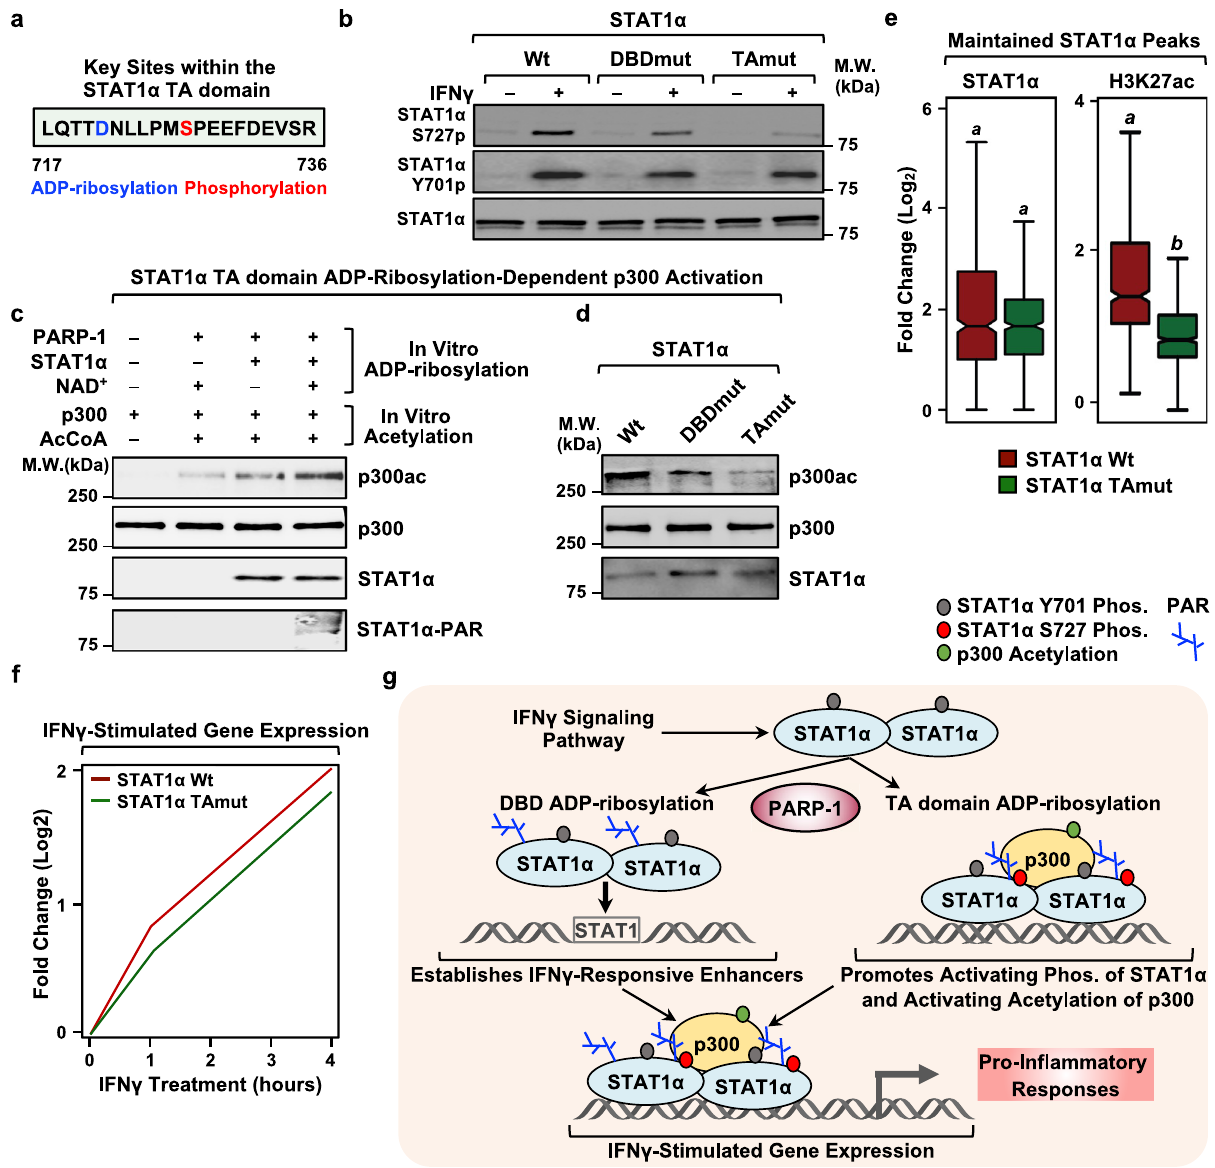
Fig. 6 ADPRylation on its TA domain is required for IFN γ -dependent phosphorylation of STAT1 α and activation of p300. a Amino acid sequence showing the ADPRylation (blue) and phosphorylation (red) sites in the TA domain of STAT1 α . b ADPRylation at D721 in the TA domain of STAT1 α is required for IFN γ -dependent phosphorylation. Immunoblots showing total STAT1 α , STAT1 α S727p and STAT1 α Y701p from iBMDMs expressing Wt, DBDmut, or TAmut STAT1 α . Uncropped immunoblots are provided as a Source Data fi le. c ADPRylation of STAT1 α stimulates p300 autoacetylation. Immunoblots showing the acetylation of p300 from in vitro reactions performed in the presence of ADPRylated STAT1 α under the conditions indicated. The immunoblots are representative of 3 independent experiments. Uncropped immunoblots are provided as a Source Data fi le. d ADPRylation of STAT1